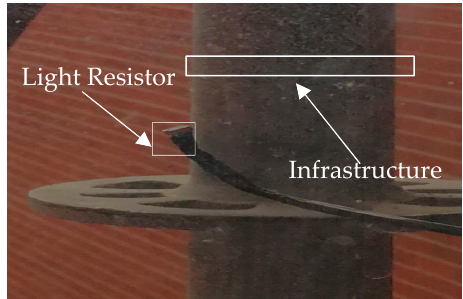
Figure 20. Obstruction of light resistor.